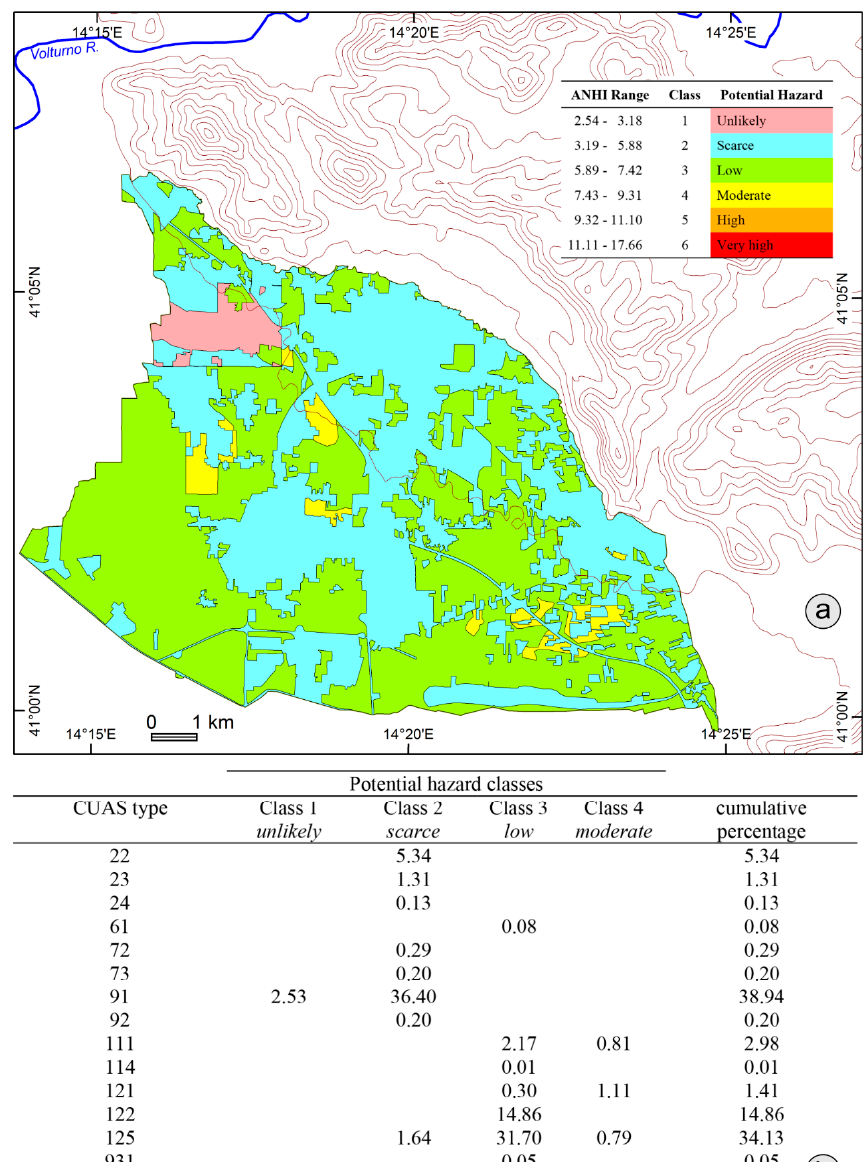
Table 6. Potential hazard ranking for the study sites.